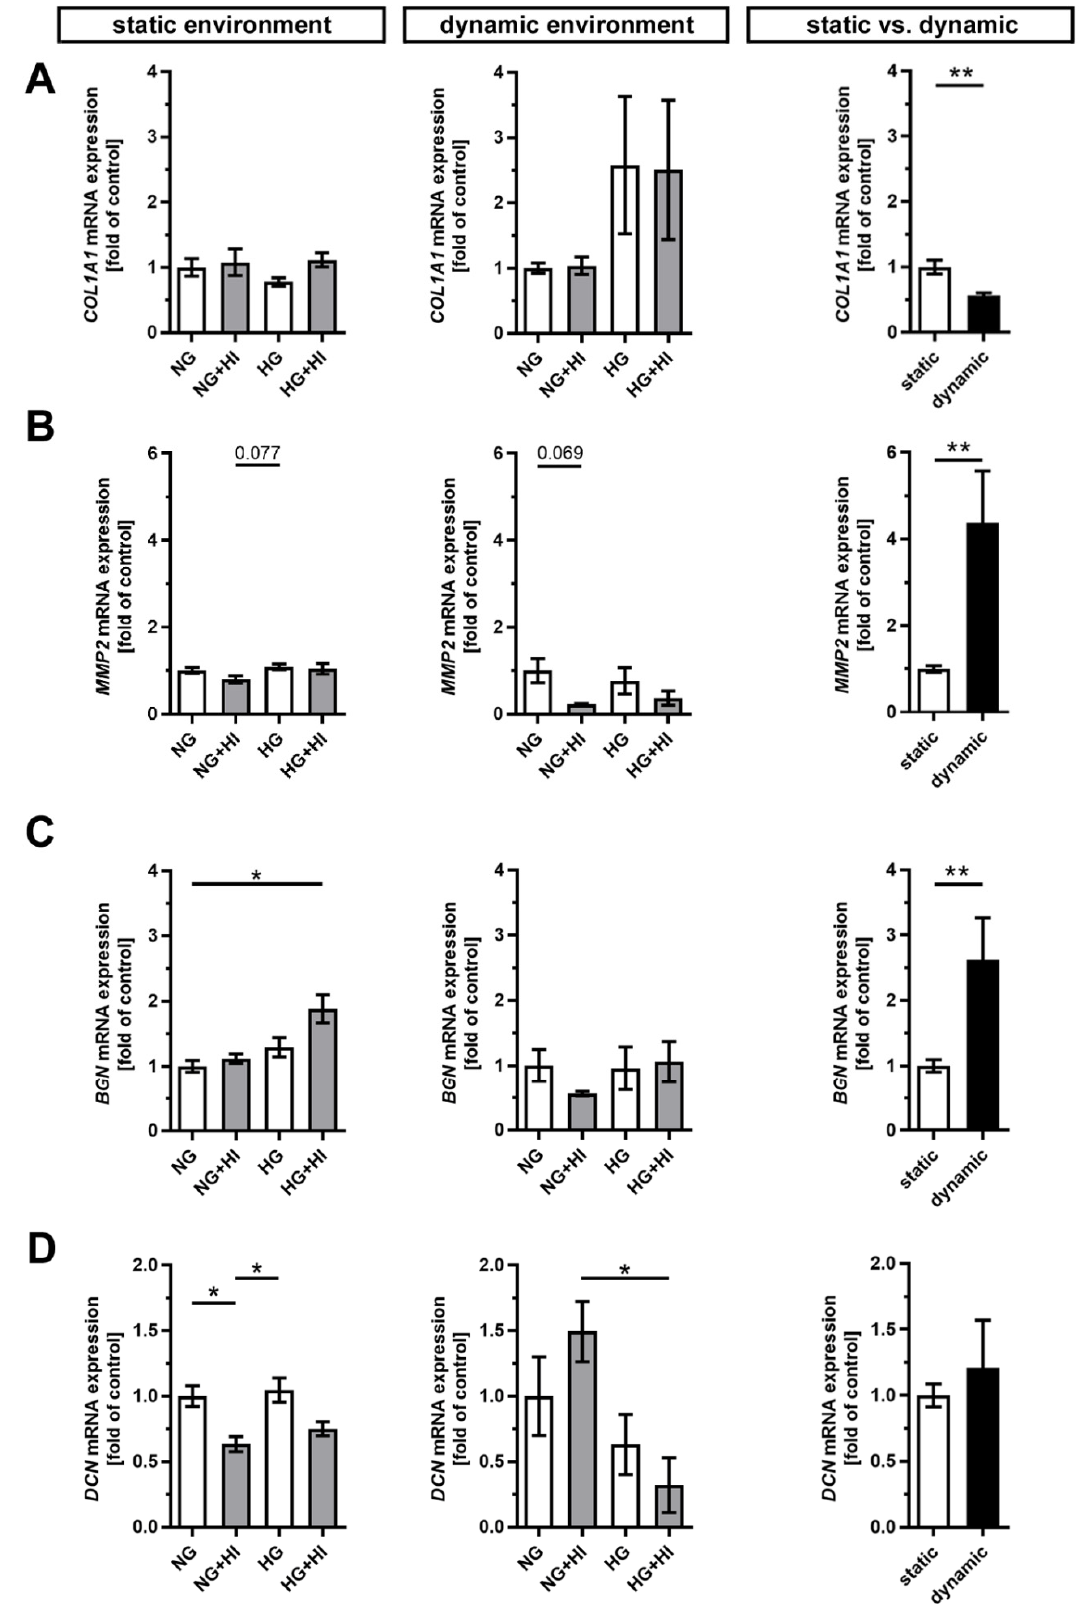
Figure 6. Gene expression of ECM molecules. ( A – D ) Gene expression of collagen type 1 alpha 1 ( COL1A1 ) and its degrading enzyme matrix metalloproteinase 2 ( MMP2 ) as well as the expressions of the small leucine-rich proteoglycans biglycan ( BGN